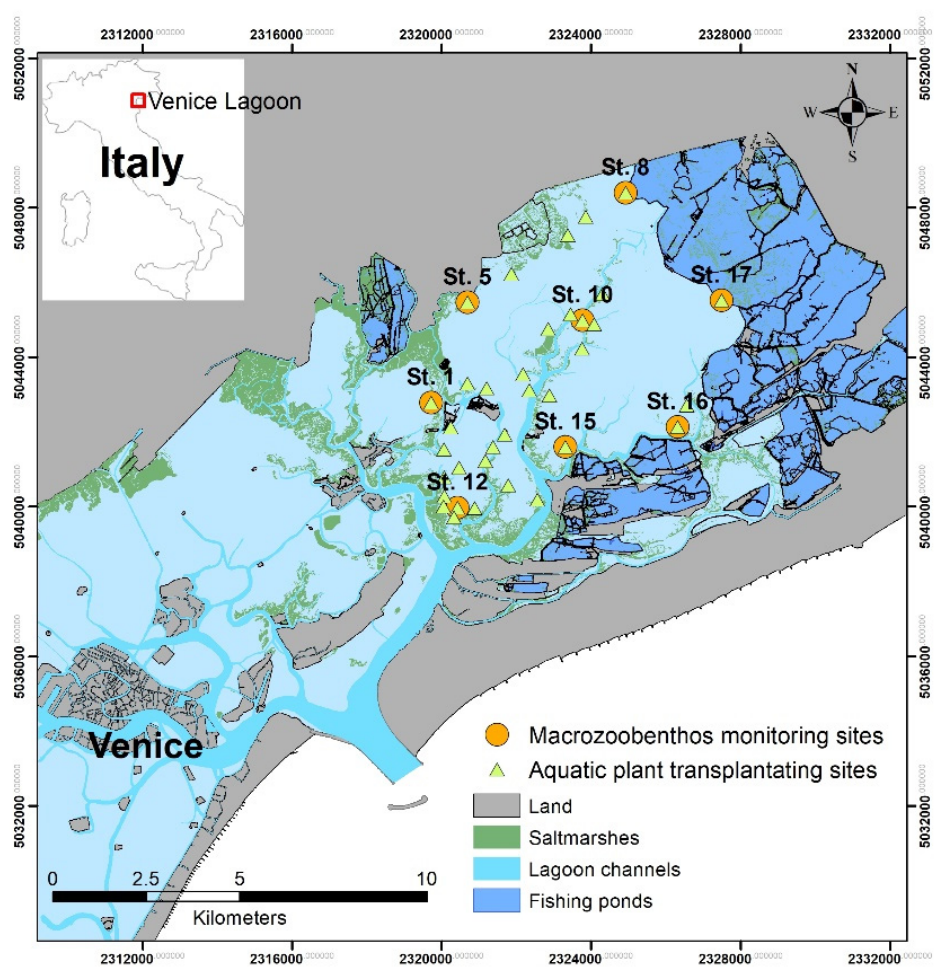
Figure 1. Map of the sampling area.